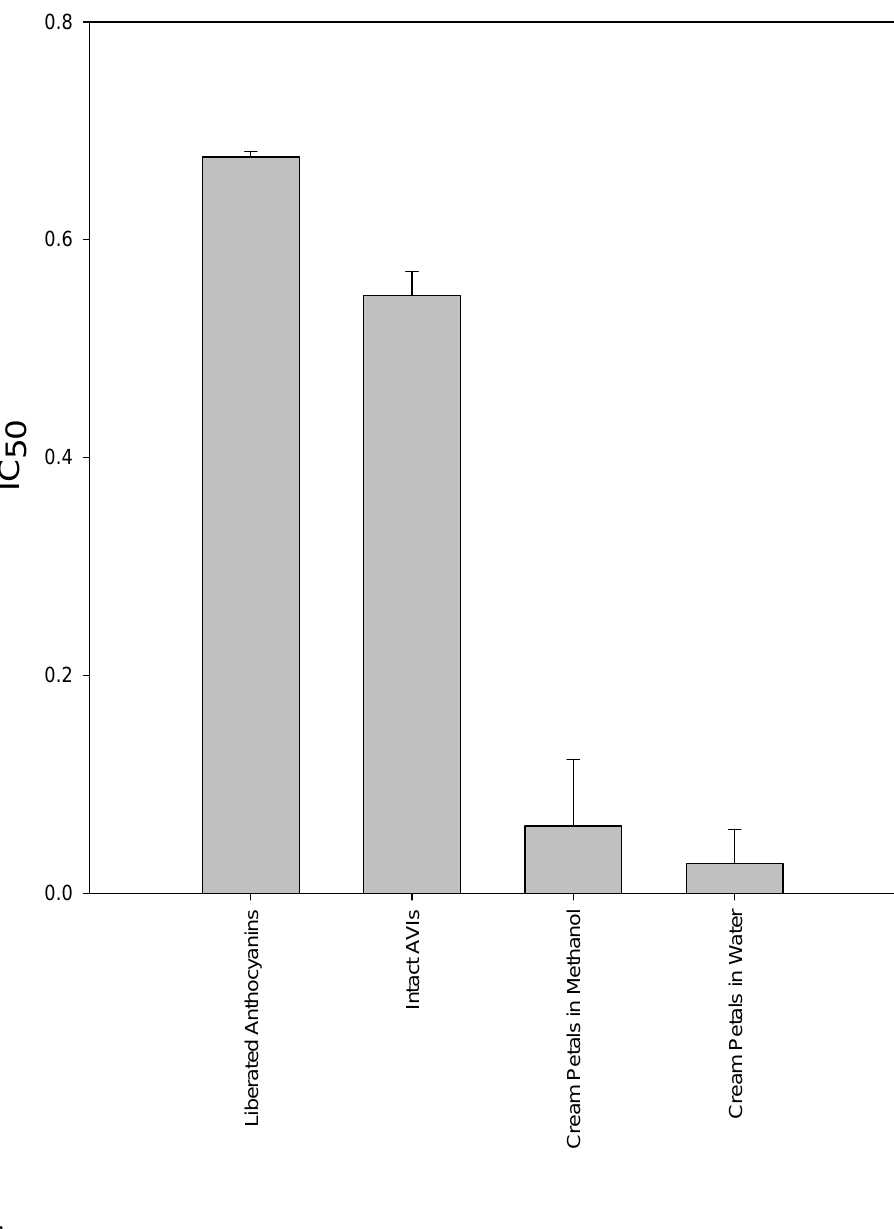
Figure 5 . Bar graph showing IC values for free anthocyanins and anthocyanin released 50 from AVIs, using the TRAP assay. The IC50 values represent the volume of extract required to reduce the absorbance of the TRAP reaction mixture by half, and were calculated from the average of duplicate